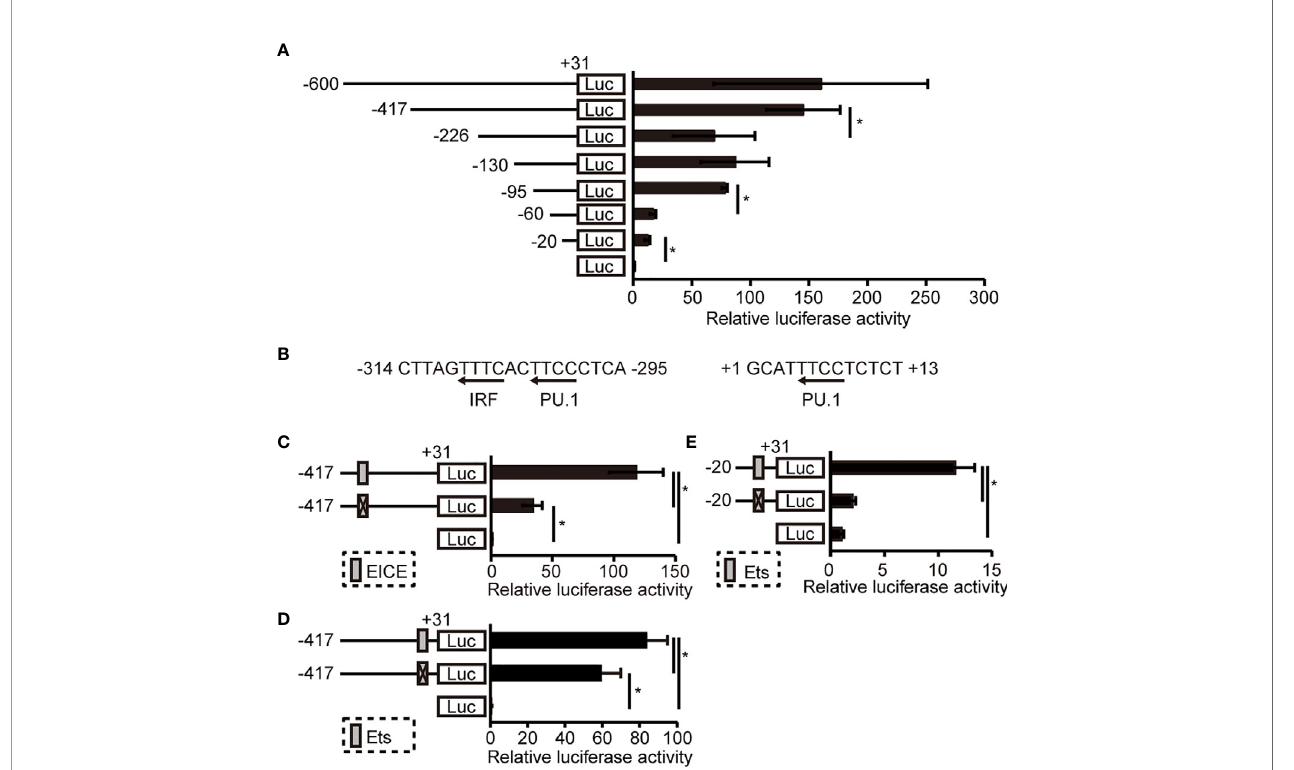
FIGURE 2 | Determination of cis element(s) in the distal promoter of hNLRP3 (A, C – E) THP-1 cells were transfected with reporter vectors containing various lengths of the distal promoter (A) or bearing mutations in the indicated sites (C – E) . Luciferase activities were determined at 48 h after transfection by normalizing fi re fl y activities to Renilla luciferase activity. (B) PU.1- and IRF-binding sites within the cis -elements. Data are expressed as the ratio to the empty vector. Data are presented as the mean + S.D. ( n = 3). * p < 0.05, two-tailed student ’ s t -test